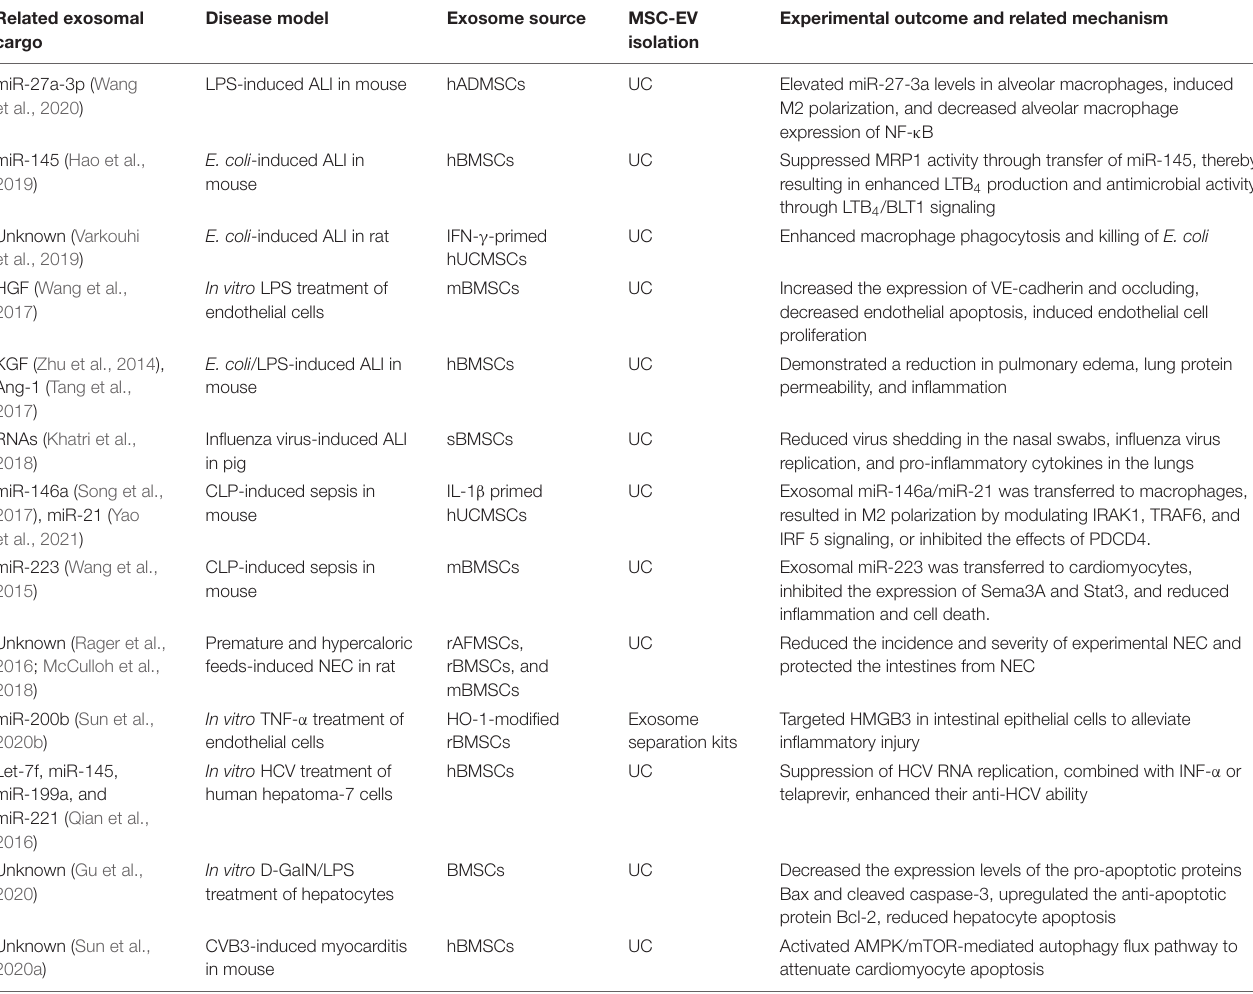
TABLE 1 | The related exosomal cargo and mechanisms of mesenchymal stem cell-derived extracellular vesicles treatment in infectious